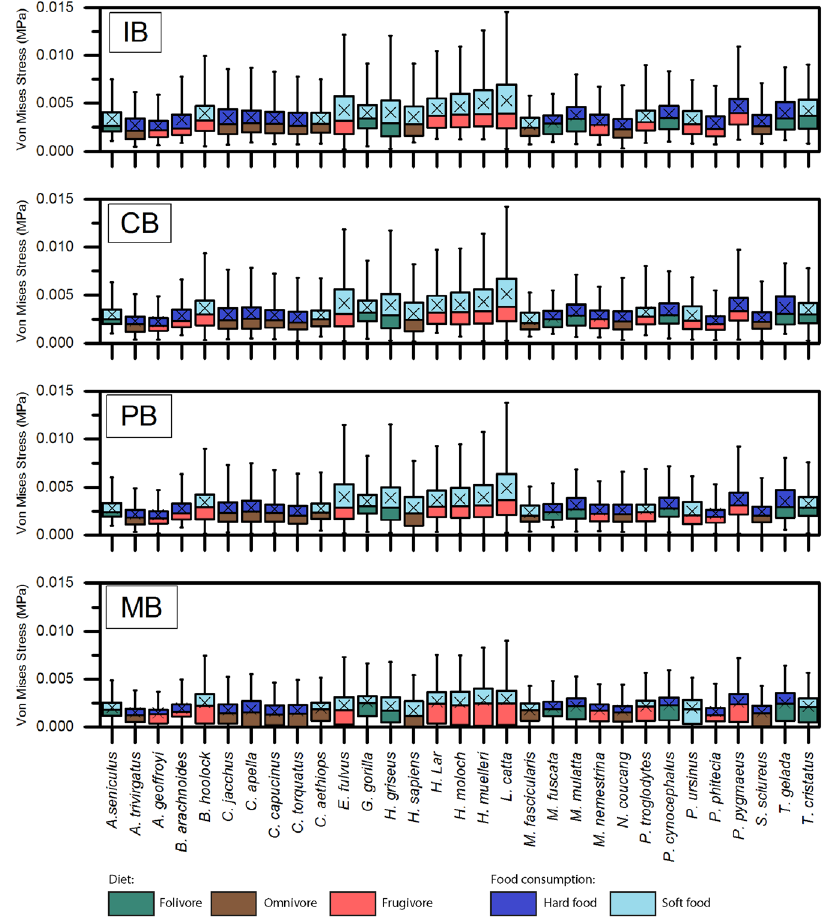
Figure 3. Box-plots of Von Mises stress distributions when QIM is assumed for the primates’ jaw analysed in the four biting cases. IB: incisive bite; CB: canine bite; PB: premolar bite and MB: molar